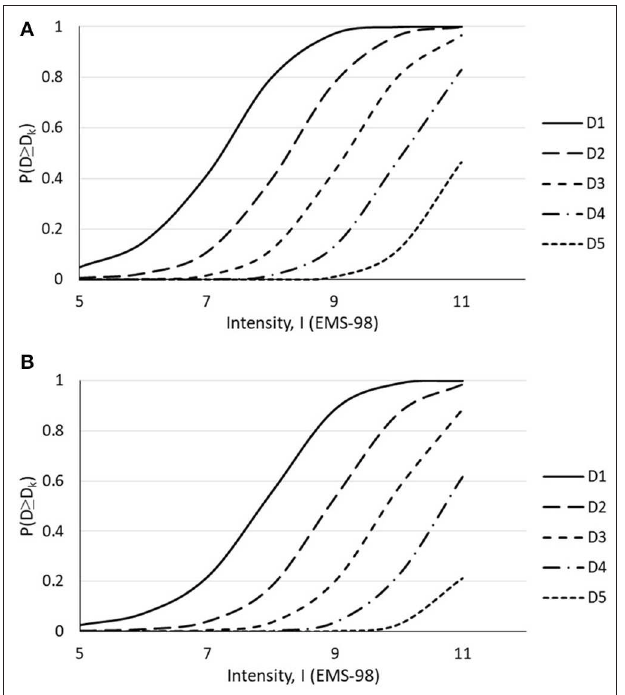
FIGURE 8 | Fragility curves as a function of intensity for (A) URM and (B) CM buildings surveyed after the Sarpol-e-zahab earthquake (original).